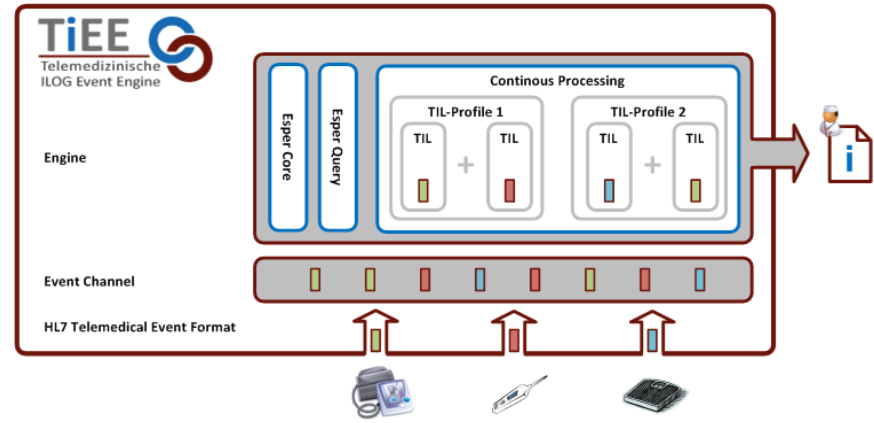
Figure 4. TiEE architectural overview based upon the event processing engine Esper